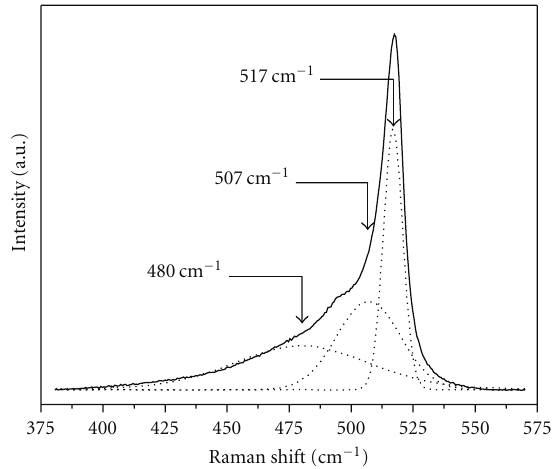
Figure 5: Deconvoluted Raman spectra for a nc-Si:H film prepared at P p = 300 mTorr with two Gaussian peaks and one Lorentzian peak and a quadratic base line, with an algorithm based on the Levenberg-Marquardt method